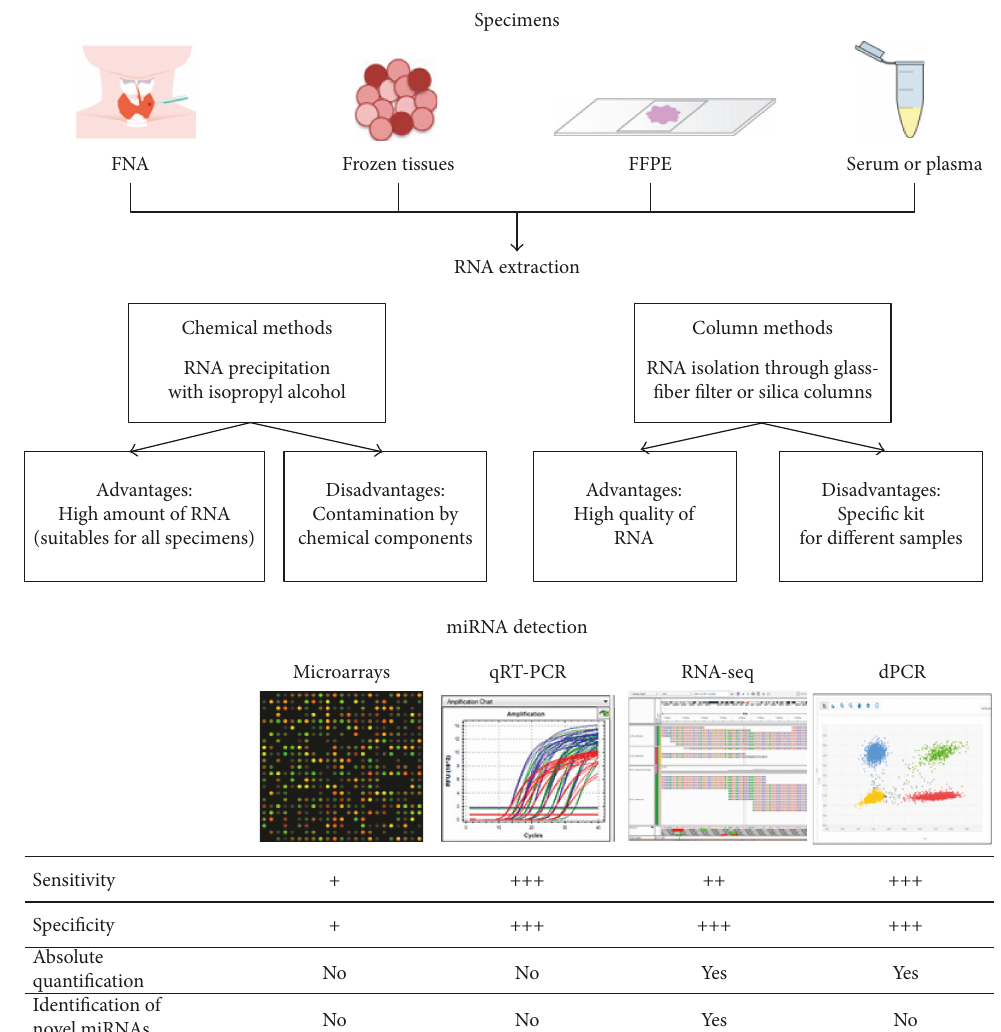
Figure 1: miRNA detection work fl ow. miRNAs can be isolated from di ff erent biospecimens. To isolate miRNAs, widely used methods are chemical and column-based techniques. After quanti fi cation step, samples are ready for miRNA pro fi ling. Among widely used techniques, there are four established methods: microarray, quantitative PCR (qRT-PCR), massive parallel sequencing (RNA-seq), and digital PCR (dPCR). The sensitivity and speci fi city are classi fi ed as follows: + (low), ++ (moderate), +++ (high). FFPE: formalin- fi xed para ffi n embedded; FNA: fi ne-needle